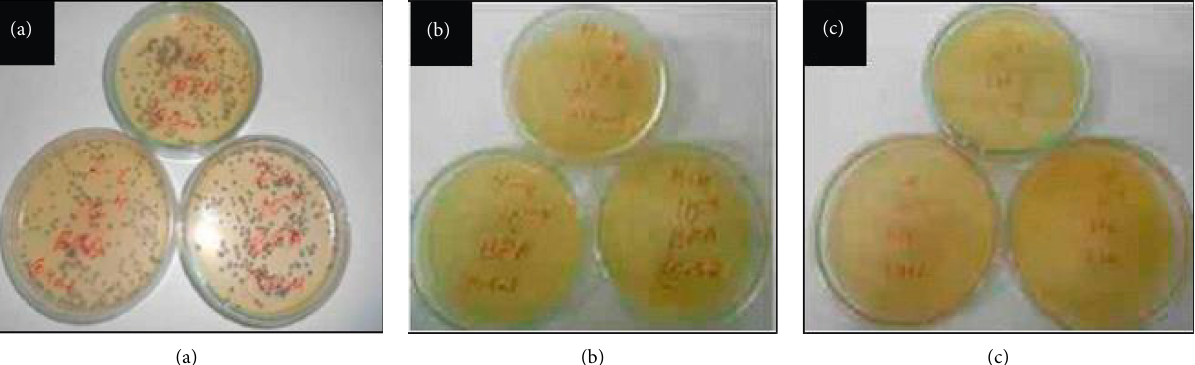
Figure 6: Bacterial reduction of (a) cotton sample, (b) 10ppm cotton/AgNP sample, and (c) 20ppm cotton/AgNP sample (adapted with permission from ref.